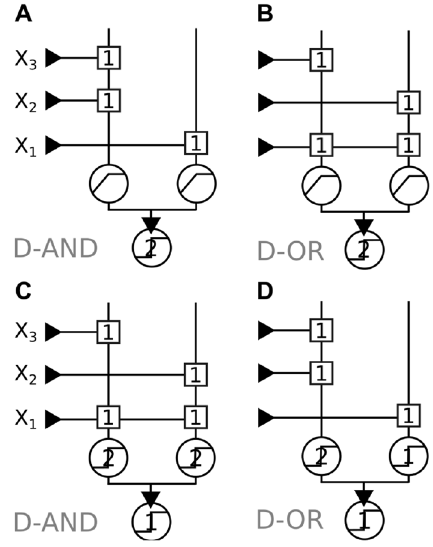
Figure 2. Minimal implementation of the Dominant AND computation (D-AND) and its dual (D-OR) by a neuron with dendrites. Squares represent synapses and circles represent transfer functions with their respective threshold/saturation values. Note that the final transfer functions (“somatic integration”) are always threshold units, whereas the transfer functions of the sub-units (“dendrites”) are threshold functions for supra-linear summation, and saturating functions (corresponding to the E function defined in Definition 5) for strictly sub-linear summation. A : D-AND implementation using sub-linear summation where X 1 targets only one dendrite. B : D-OR implementation, in this case X 1 targets two sub-linear dendrites. C : D-AND implementation using supra-linear summation, where X targets two dendrites. D : D-OR 1 implementation, X in this case targets only one 1